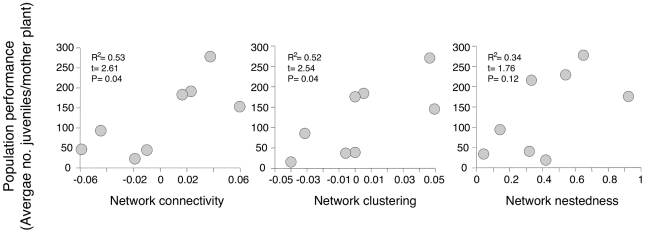
Relationship between network architecture and function.The complex networks of pollinator-mediated interactions among individual plants (e.g., mating events) benefit E. mediohispanicum population performance. Populations organized around a core of highly interactive plants (high nestedness) with individuals tightly connected through shared pollinators (high connectivity) within distinct groups exhibiting similar pattern of interactions (high clustering) have high performance (number of juveniles produced per plant).